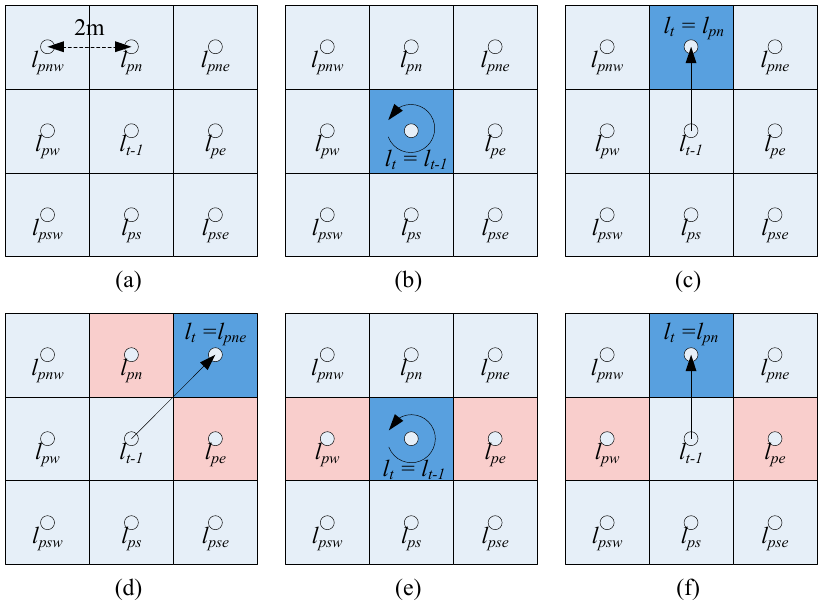
Figure 3. Schematic of the fuzzy pattern recognition algorithm: ( a ) nine RPs in a grid area and the interval of the RPs is 2 m; ( b ) l t = l t − 1 when the RSSI has no variation or a similar variation in four directions; ( c ) l t = l pn when the RSSI variation trend follows the trajectory from P 0 to P n ; ( d ) l t = l pn when the RSSI has a similar variation trend in the north and east, we assume the RSSI variations follow the trajectory from P 0 to P ne ; ( e ) l t = l t − 1 when the RSSI has a similar variation in the east and west; ( f ) l t = l pn when the RSSI has a similar variation in the east, west and north, we assume the RSSI variations follow the trajectory from P 0 to P n